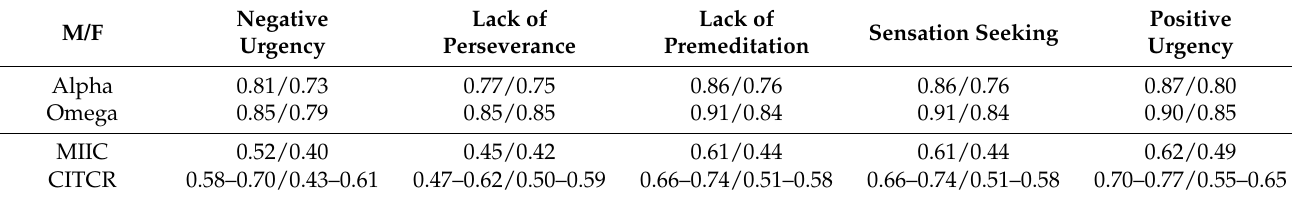
Table 5. Internal consistency of the